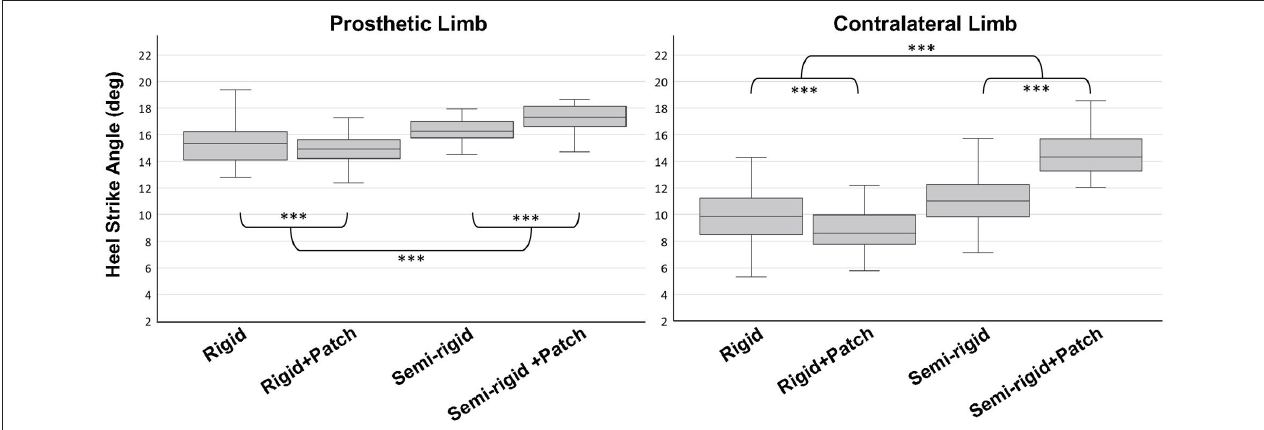
FIGURE 8 | Heel strike angle in the 4 prosthetic interface conditions for the prosthetic (left) and the contralateral limb (right). For both limbs, the effect of the patch on the heel strike angle depended on the socket type ( p < 0.001). *** p <